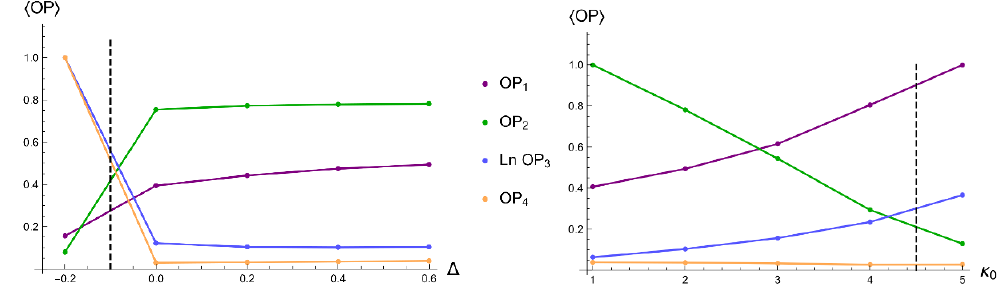
Figure 9 . Behaviour of the order parameters OP 1 , . . . , OP 4 , de(cid:12)ned in eqs. (4.1){(4.4), in CDT with toroidal spatial topology ((cid:6) = T 3 ) and (cid:22) N = 80000, t tot = 40. The left plot shows the OPs (4 ; 1) as a function of (cid:1) for (cid:12)xed (cid:20) 0 = 2 : 0, which corresponds to a vertical line in the phase diagram in (cid:12)gure 7, and the right plot shows the OPs as a function of (cid:20) 0 for (cid:12)xed (cid:1) = 0 : 6, which corresponds to a horizontal line in the phase diagram in (cid:12)gure 7. The OP 1 , OP 2 and OP 4 were rescaled to (cid:12)t into a single plot, and due to a very large range of OP 3 (a few orders of magnitude) we plot the rescaled ln OP 3 instead of OP 3 , the rescaling in the left and right plots being the same. The qualitative behaviour of the OPs is the same as for phases A , B and C dS in CDT with spherical spatial topology (see (cid:12)gure 5 and table 1). Approximate positions of the B (cid:0) C and the C (cid:0) A phase transitions are marked by dashed lines on the left and right plots,